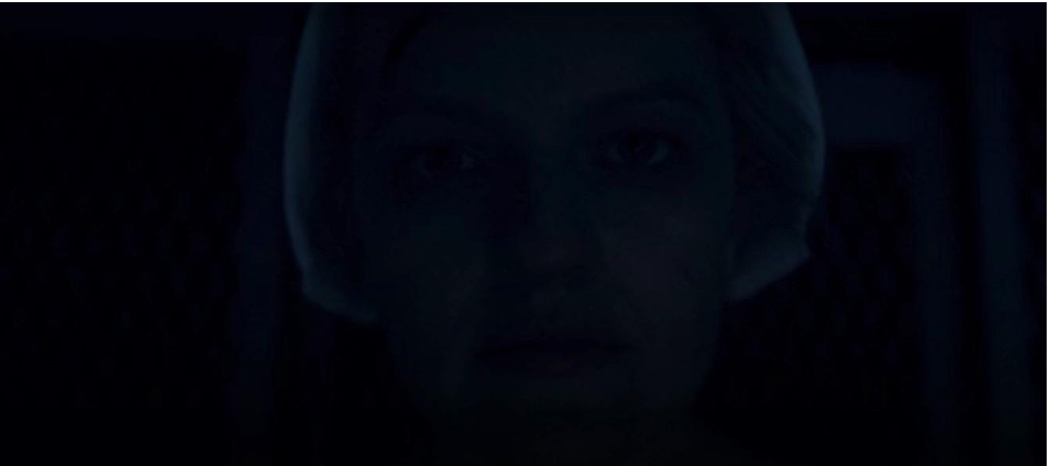
Figure 4: June ( Elisabeth Moss ) returning the viewer ’ s look from the darkness without in The Handmaid ’ s Tale S1Ep10 ( “ Night ” )